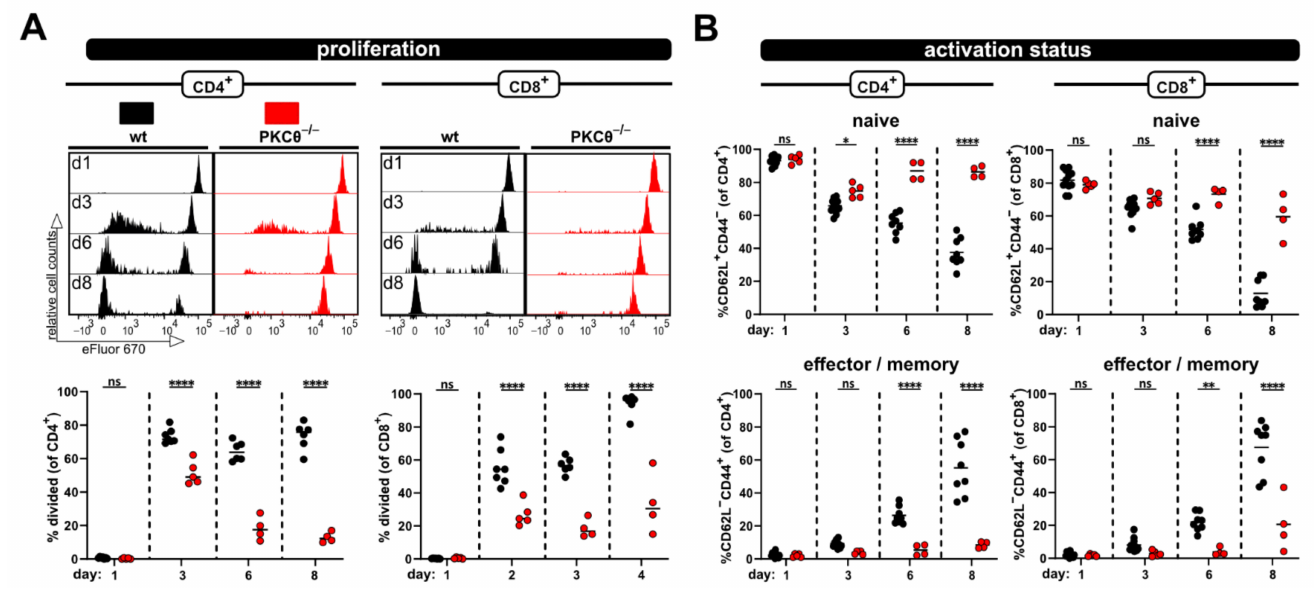
Figure 4. Impaired allogen-induced activation of PKC θ -deficient T-cells can be detected in blood. ( A ) Proliferation and ( B ) CD4 + and CD8 + T cell subsets (naive and effector/memory) were analyzed at the same time points by flow cytometry from blood. Data are represented as individual values plus mean. Data are represented as individual values plus mean. Representative FACS histograms of individual mice are shown. ns = not significant, * p < 0.05, ** p < 0.01, **** p < 0.0001; one-way ANOVA following Bonferroni’s post hoc